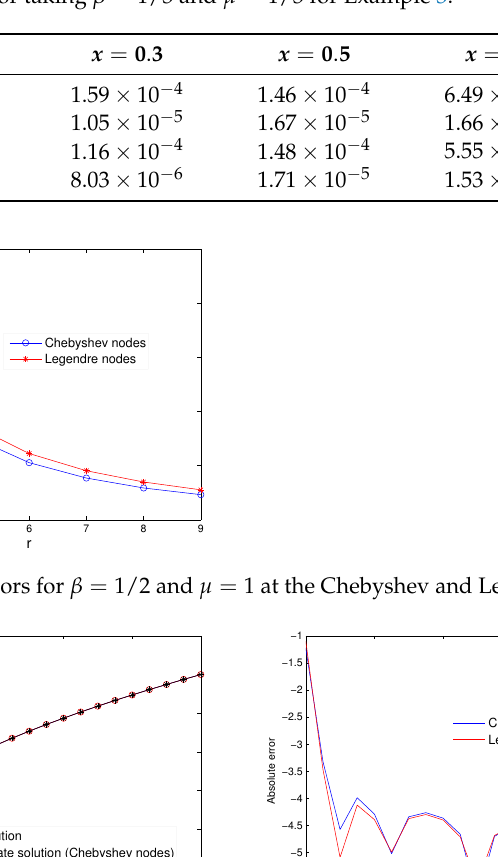
Exact solution Approximate solution (Chebyshev nodes) Approximate solution (Legendre nodes)